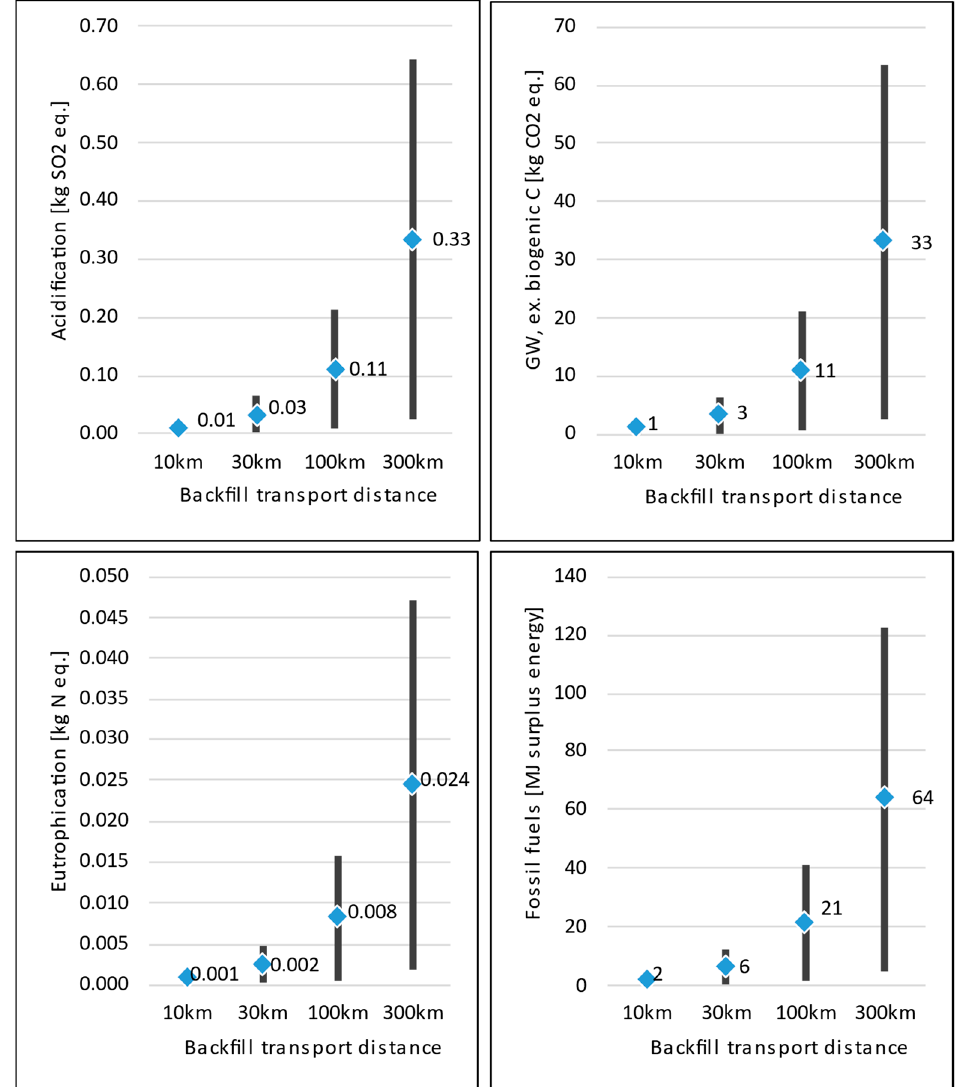
Figure 6. Traci 2.1 midpoint impact of box backfill transportation distance shows the increase in potential impact with additional distance of transport. Diamonds represent the midpoint, and the black bars represent the range. Transport of gravel backfill for the arch yields a similar profile. (Supplementary Materials Figure SI-14).